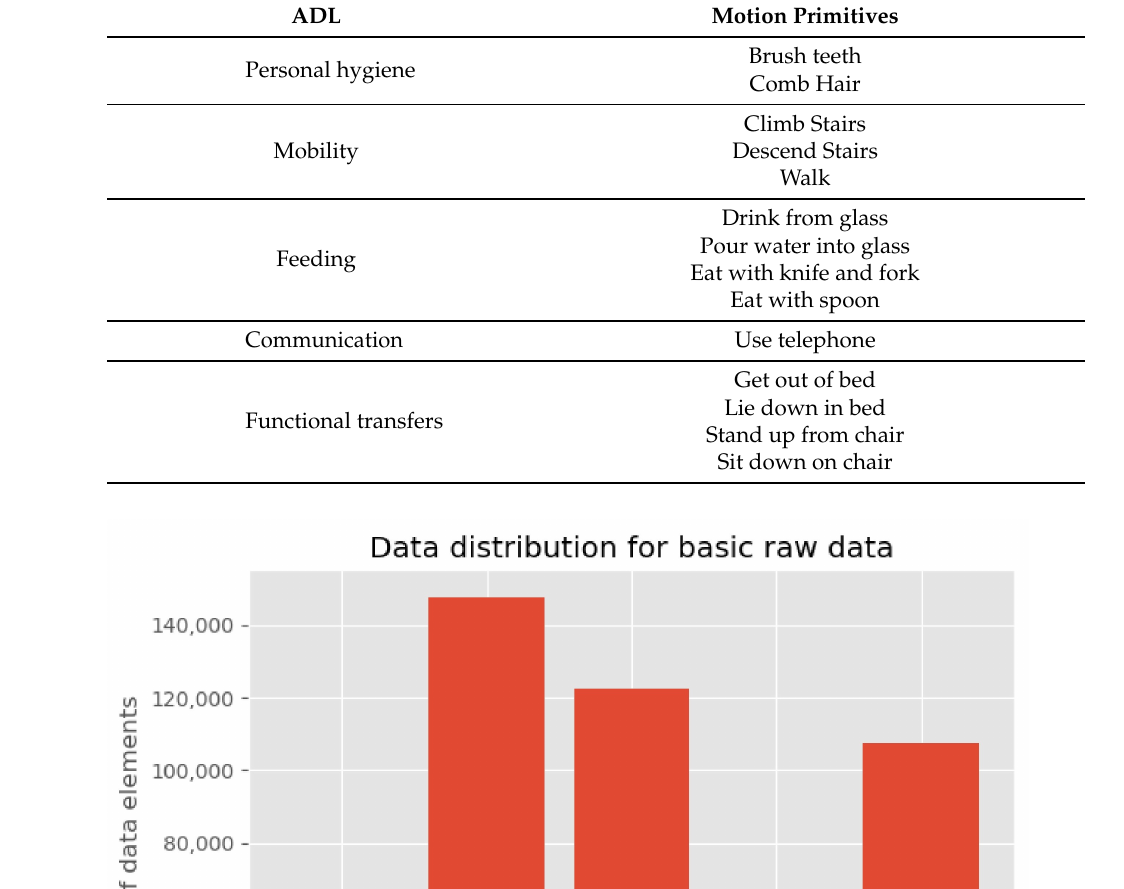
Table 1. Correlation between ADL categories and Motion primitives.